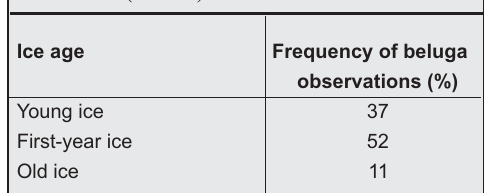
Table 3. Ice conditions at the locations of beluga observations (n = 308)